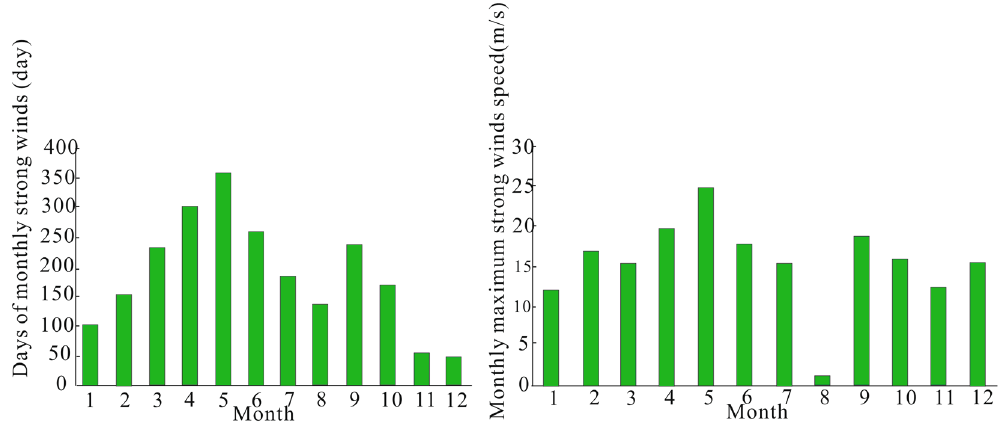
Figure 5. Total days of monthly gales and monthly maximum gales speed from Dingqing weather station